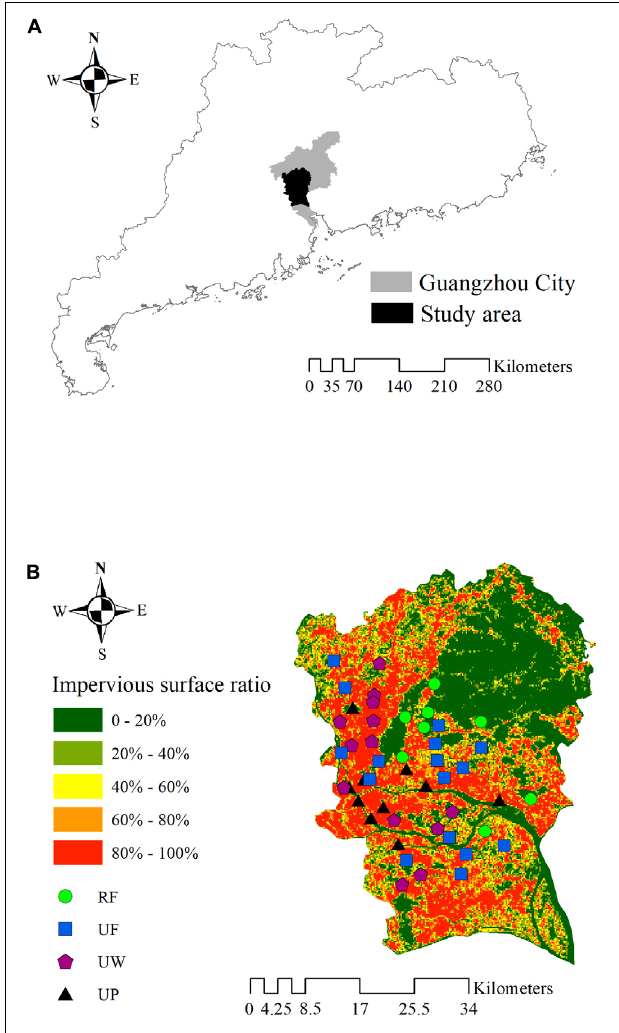
FIGURE 1 | (A) Locations of the study areas in Guangdong Province. (B) Impervious surface ratio of the study area and location of the 47 sites in downtown and the adjacent regions in Guangzhou City. RF, rural forest; UF, urban forest; UW, urban woodland; UP, urban